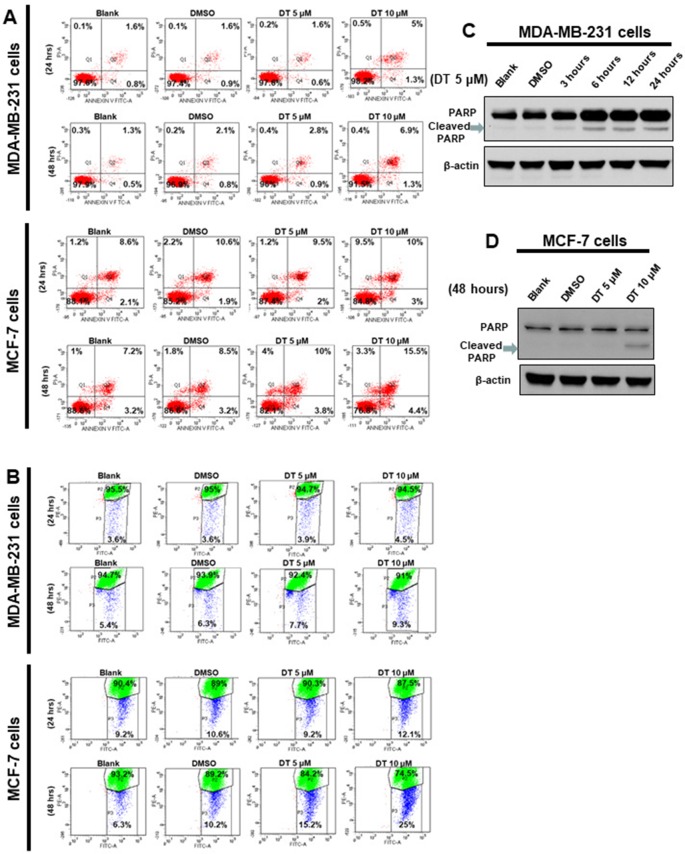
Dihydroisotanshinone I (DT) induces apoptosis in breast cancer cells. MCF-7 cells or MDA-MB-231 cells were treated without or with indicated compounds for 24–48h. Cell apoptosis was detected by flow cytometry with annexin-V-FITC/PI dual staining or mitoscreen JC-1 staining. (A) For annexin-V-FITC/PI dual staining, the representative histograms of flow cytometric analysis using double staining with annexin-V-FITC (FITC-A) and PI (PI-A). (B) For mitoscreen JC-1 staining, dot Plots revealing depolarization of mitochondria in treated indicated breast cancer cells. The percentage of events in the upper gate (P2) and lower gate (P3) represent population of treated indicated breast cancer cells having normal and depolarized mitochondria respectively. (C, D) Total cell extracts of MDA-MB-231 cells (C) or MCF-7 cells (D) were harvested from cells treated with DMSO or indicated concentrations of DT for indicated hours. The protein was immunoblotted with polyclonal antibodies specific for PARP. β-actin was used as an internal loading control.